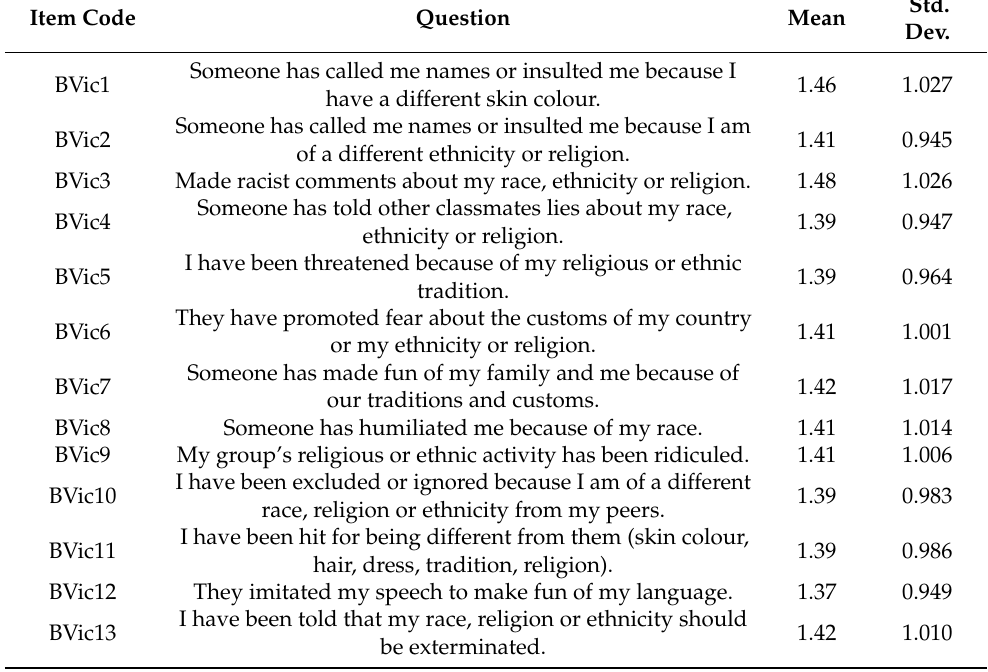
Table 4. Descriptive statistics of the